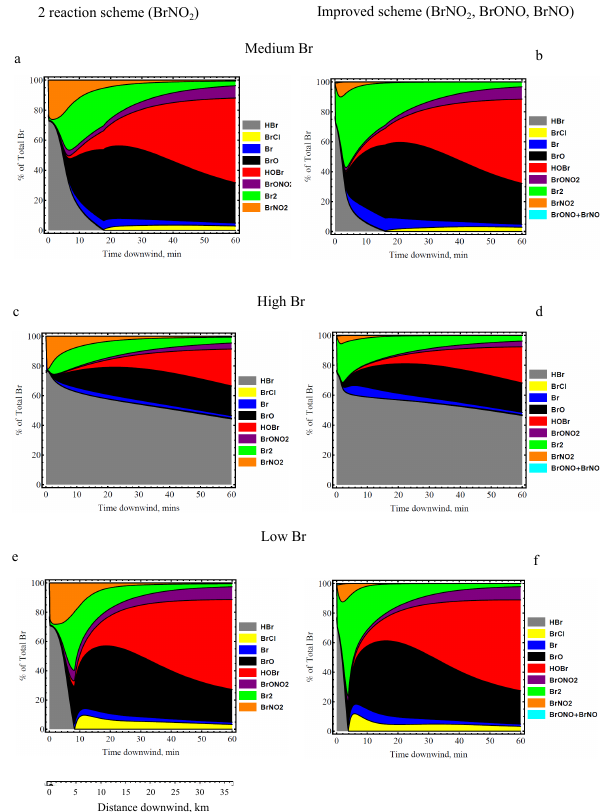
Figure 5. Br speciation in model runs that also include formation of BrNO 2 , shown for the three bromine emission scenarios. Simu- lations incorporate BrNO 2 using a 2-reaction scheme (a, c, e) or a 12-reaction scheme including BrNO 2 , BrONO and BrNO (b, d, f) . See text for